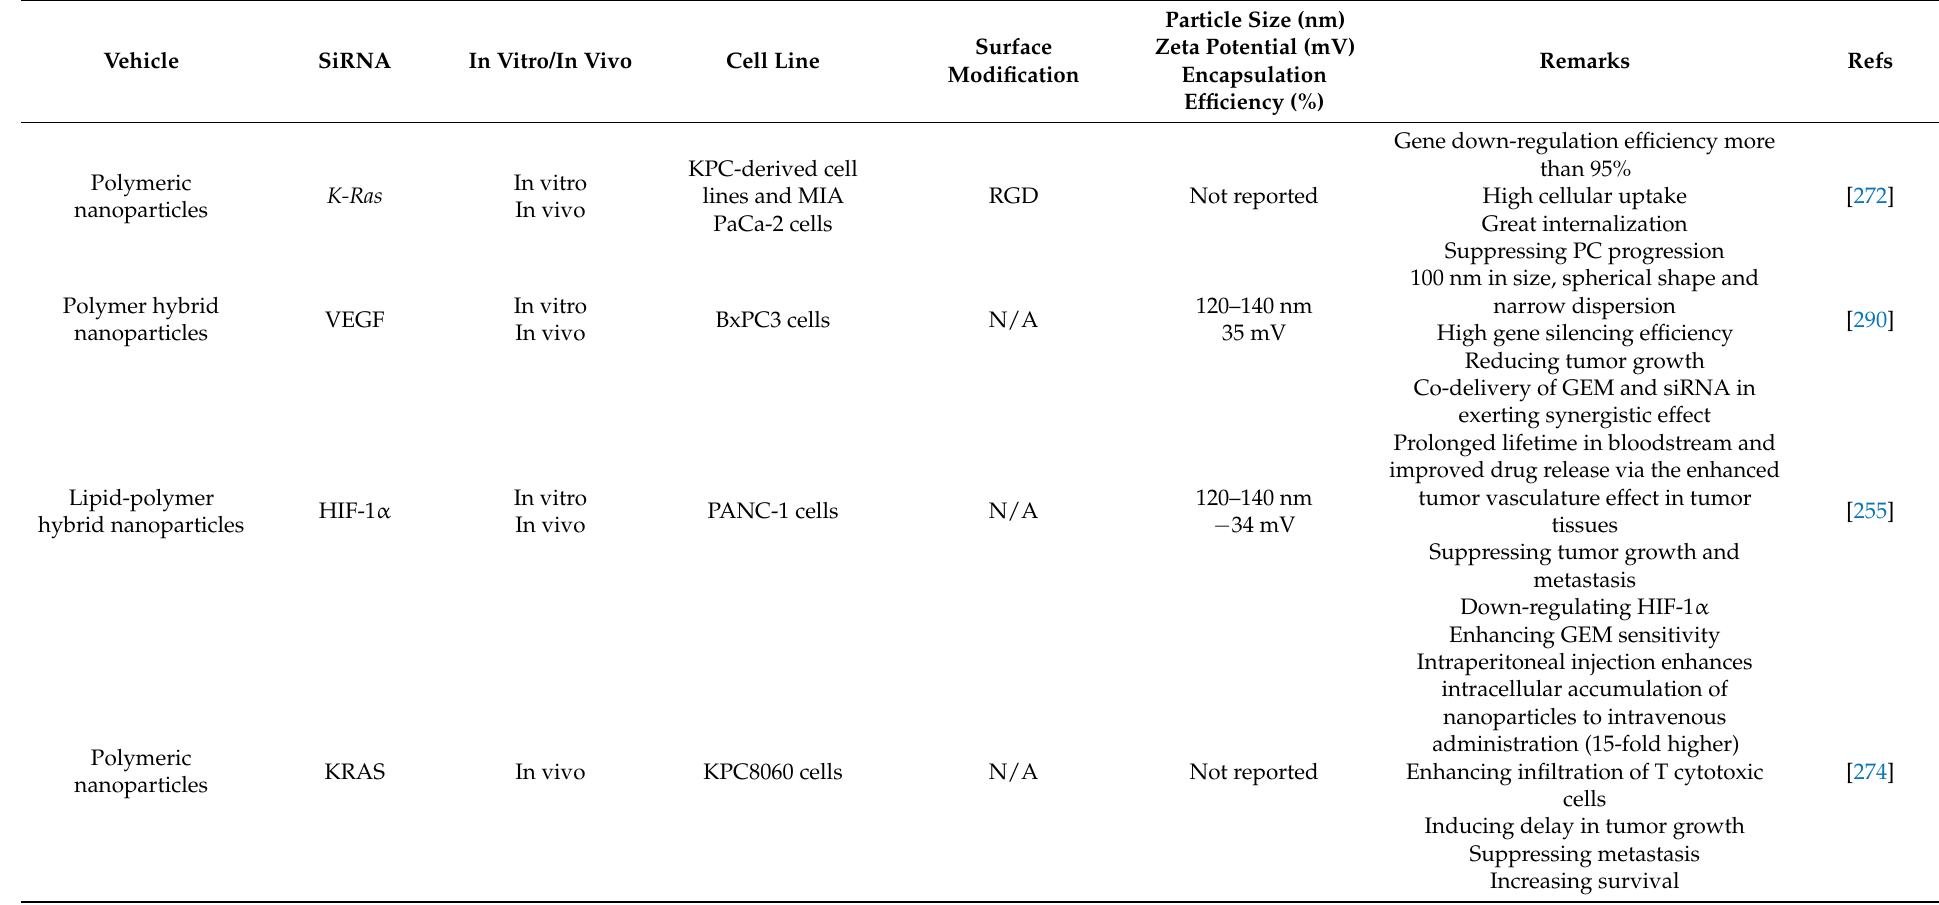
Table 3. Co-delivery systems for siRNA in PC